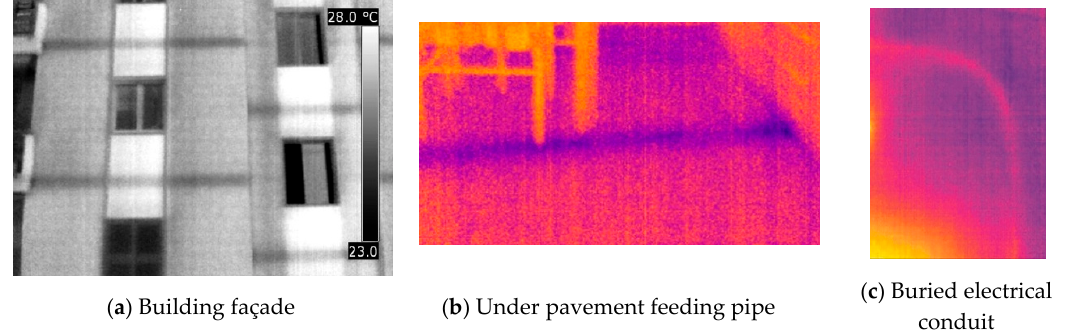
Figure 18. Thermal images from industrial application. ( a ) Fault in a motor; ( b ) fault in a contactor. Figure 19. Infrared thermography at home: outside ( a ); inside ( b , c ).